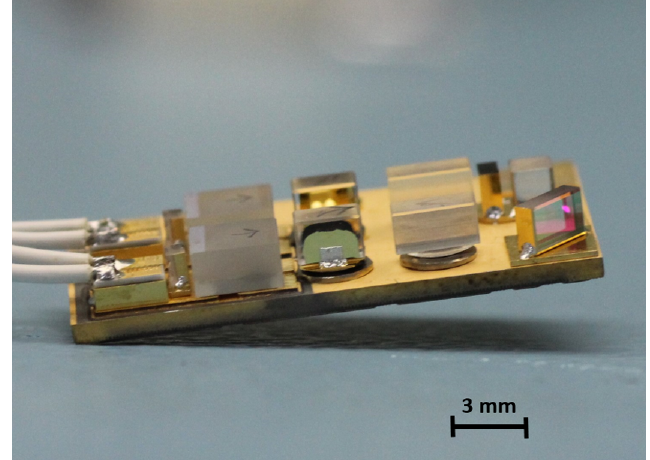
Figure 7. Resulting soldered laser